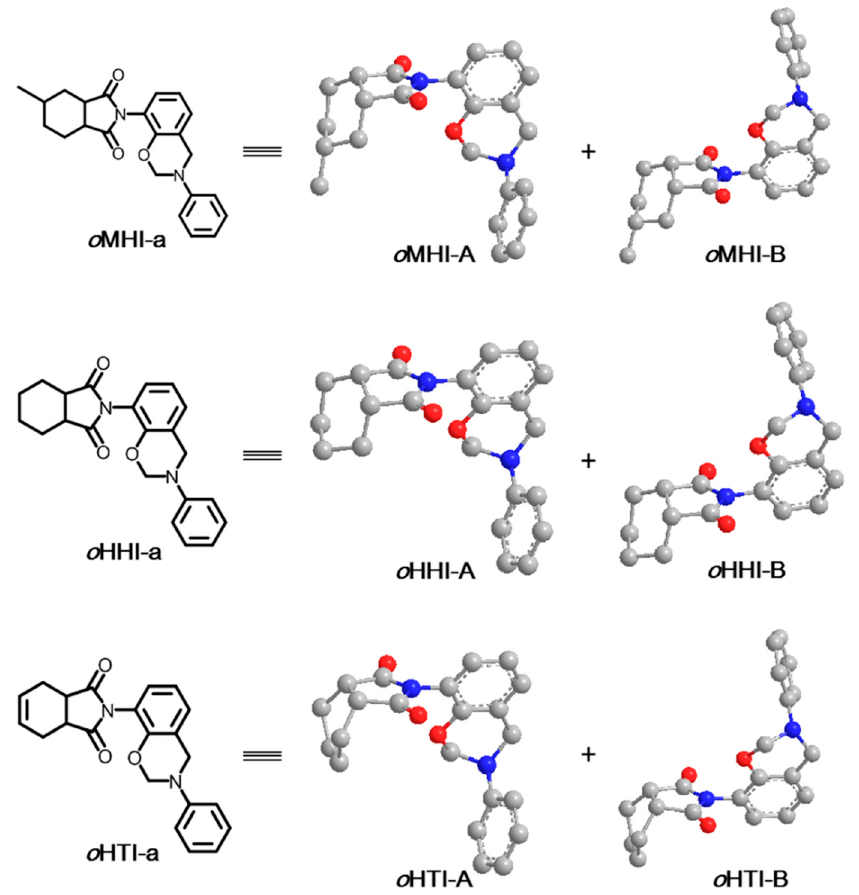
Figure 2. ( a ) 13 C NMR spectra of o -MHI-a, o HHI-a and o HTI-a. ( b ) The expanded region between 45 and 90 ppm showing the two sets of doublet resonances for these monomers.